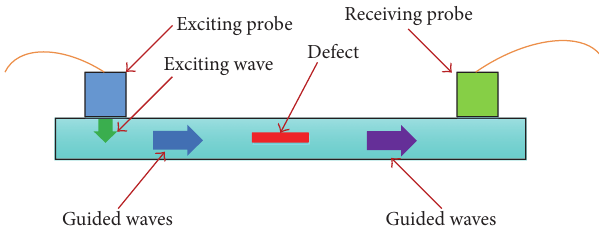
Figure 14: The diagram of the testing principle.